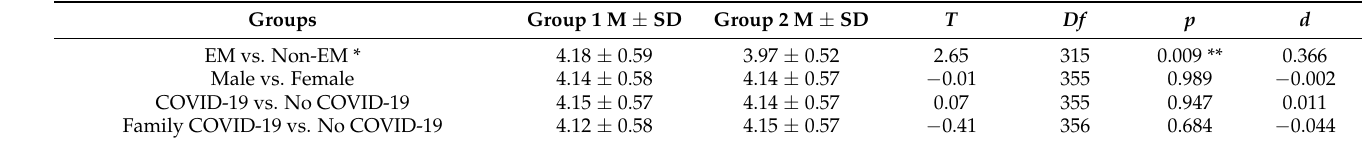
Table 3. T -tests exploring differences in burnout.